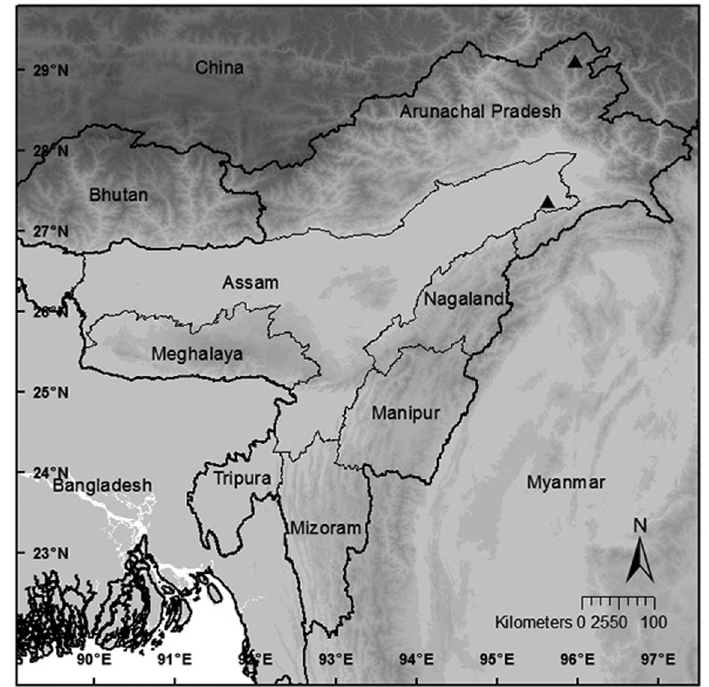
Fig. 27. Map showing the location of B. handelii Irmsch.